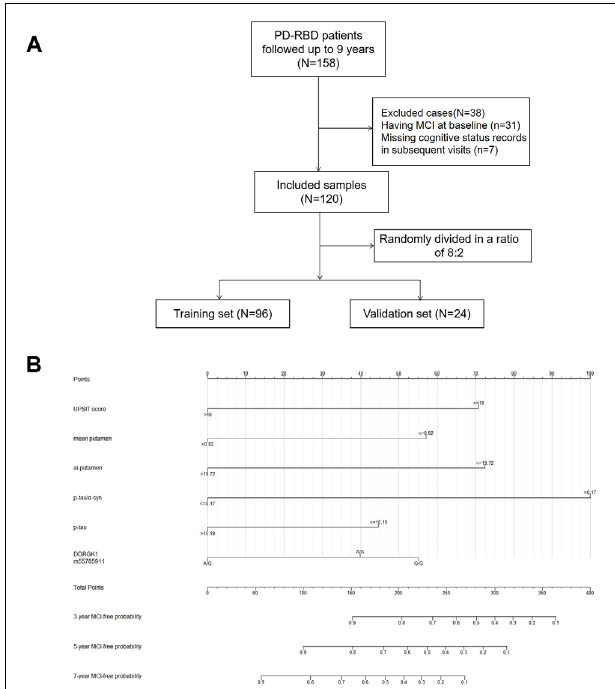
FIGURE 2 | Flow diagram of patient selection and allocation (A) and nomogram for predicting the MCI-free probabilities at 3, 5, and 7 years in PD-RBD patients (B) . Each level of every predictor corresponds to a score on the points scale, and the total points were acquired by adding the scores of each variable. The total points for each patient correspond to the estimation of the 3-, 5-, and 7-year probabilities of MCI-free survival in this nomogram. Abbreviations: PD, Parkinson’s disease; RBD, Rapid eye movement sleep behavior disorder; MCI, mild cognitive impairment; ai, asymmetry index.